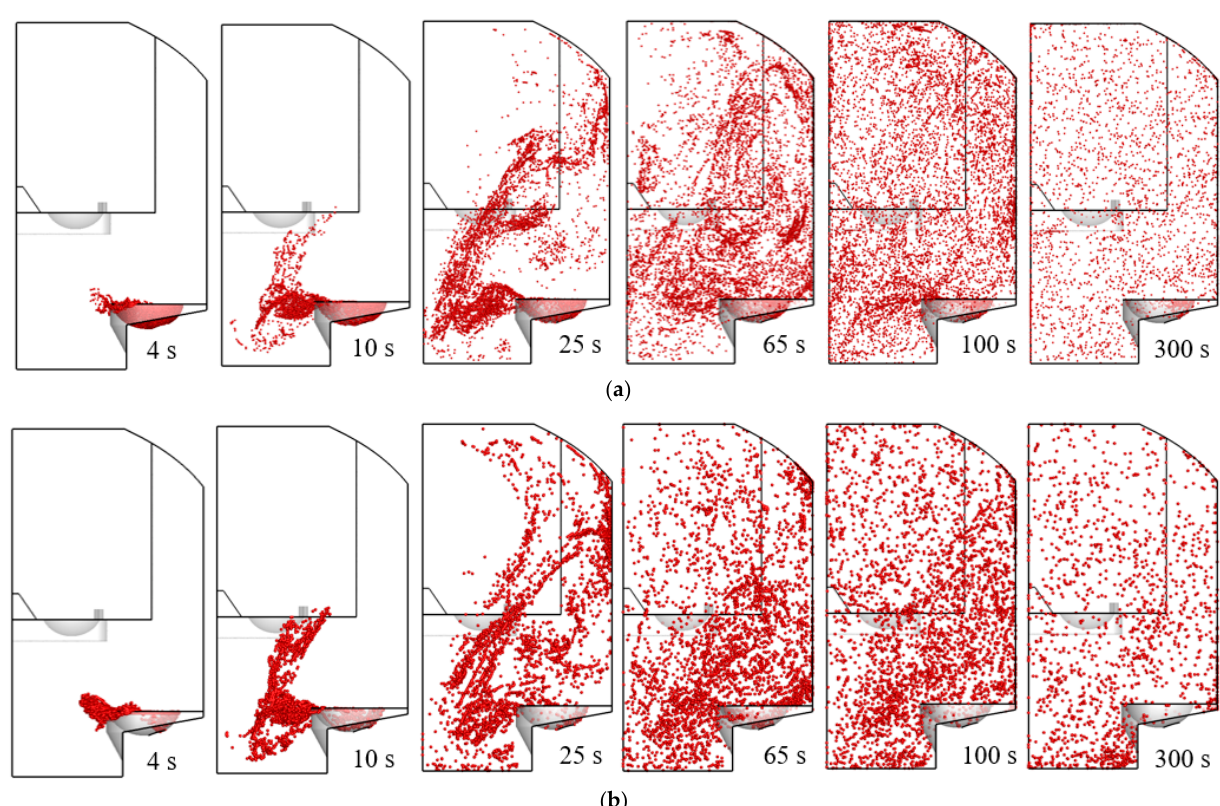
Figure 7. Time series of fecal aerosol distribution patterns for Case 1: ( a ) 1 µm; ( b ) 10